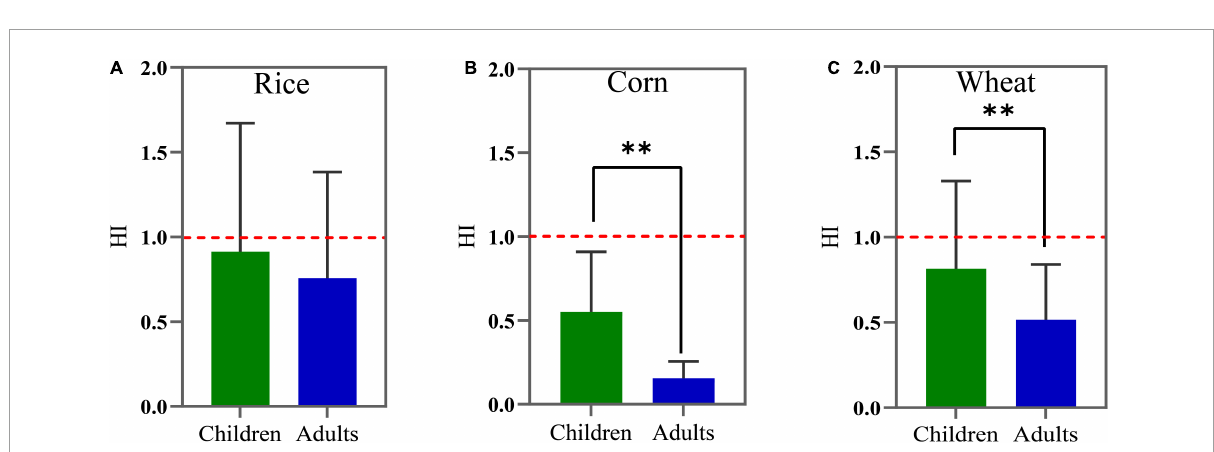
FIGURE6 The hazardous index (HI) values for rice (A) , corn (B) , and wheat (C) grains consumption by children and adults. The red dashed line denotes the limit value of HI (1.0). ∗∗ p <